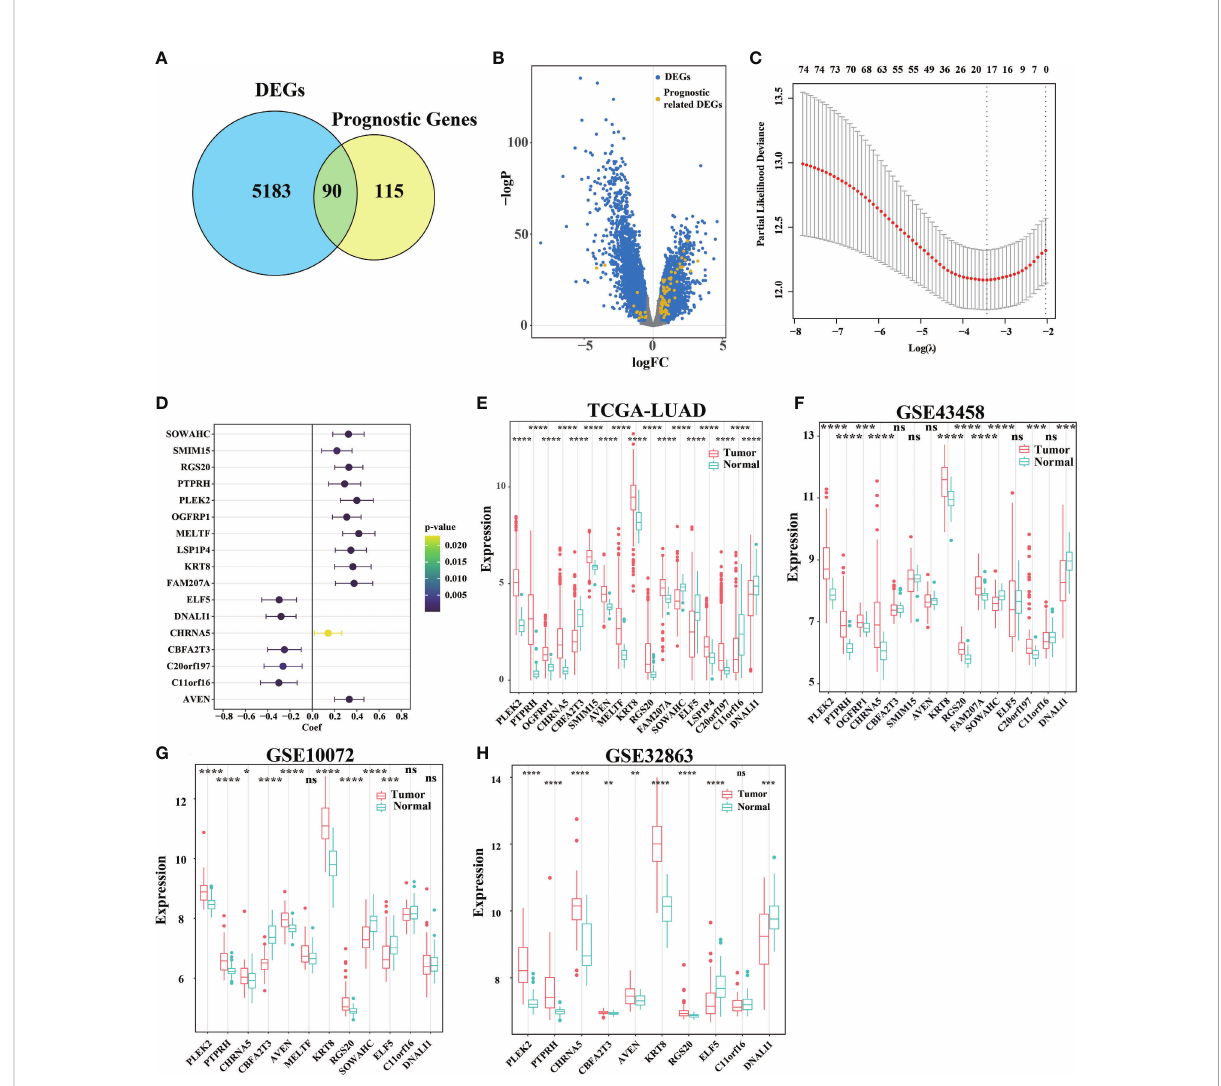
FIGURE 1 Identi fi cation of signature genes and establishment of a survival model. (A) A total of 5273 DEGs with adj. pvalue< 0.05 and logFC > 0.5 or logFC< -0.5 were selected by limma. 205 genes related to survival were found by stationarity test and univariate Cox regression analysis. Of these, 90 genes were associated with both survival and differential between the cancer and para-cancer groups. (B) Use volcano map to describe the distribution of DEGs in all genes. (C) LASSO Cox regression model was used to establish a multivariable model, and 10-fold cross validation was used to calculate the total deviation corresponding to differe nt penalty coef fi cients. (D) Univariate Cox regression test (C) The in fl uence of the gene on survival (upper and lower 95% con fi dence intervals, color signi fi cance). (E) Analysis of gene expression differences between primary cancer (n = 533) and adjacent tissue (n = 59) in TCGA-LUAD. (F – H) DEGs in tumor tissue and para-cancer tissue in GEO databases (ns was non-signi fi cant, *P< 0.05, **P< 0.01, ***P< 0.001, ****P<